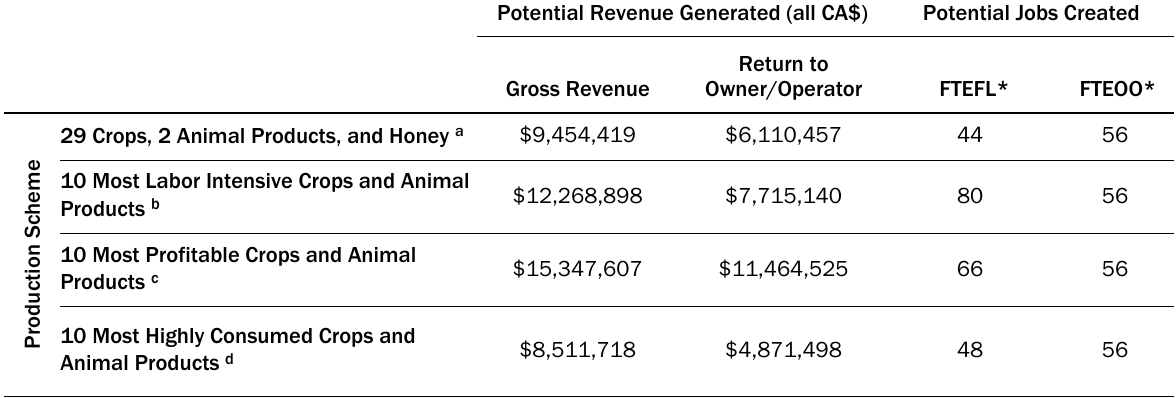
Table 4. Economic and Job Creation Potential of 113 ha (279 acres) of Municipally Owned Underutilized ALR Land in Surrey, B.C., Under Four Production Schemes